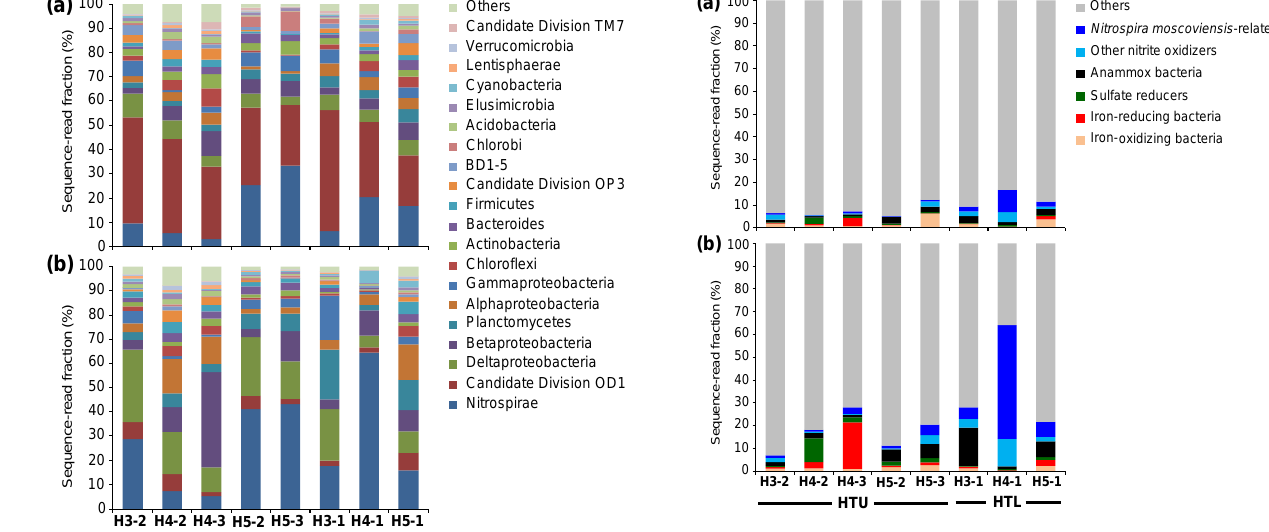
Figure 9. Fractions of sequence reads affiliated with iron oxidiz- ing or iron reducing bacteria, sulfate-reducing bacteria, anammox bacteria, and nitrite oxidizers ( Nitrospira moscoviensis -related and others) within the bacterial community (a) DNA-based analysis, (b) RNA-based analysis. Only those sequence reads were consid- ered which were unambiguously classified to described taxa on the genus